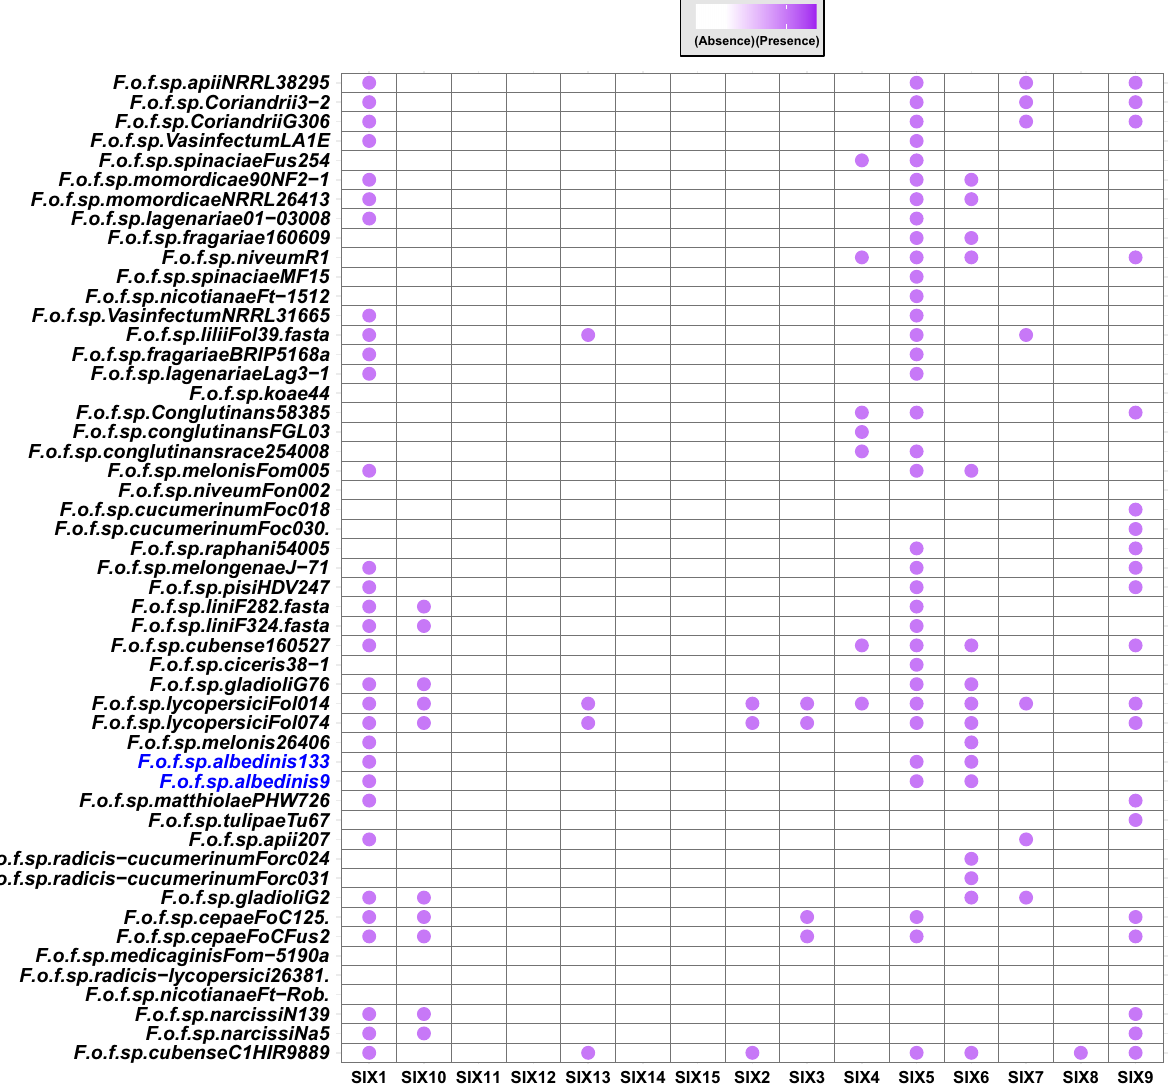
F.o.f.sp.cucumerinumFoc030.F.o.f.sp.cucumerinumFoc018F.o.f.sp.niveumFon002F.o.f.sp.melonisFom005F.o.f.sp.conglutinansrace254008F.o.f.sp.conglutinansFGL03F.o.f.sp.Conglutinans58385F.o.f.sp.koae44F.o.f.sp.lagenariaeLag3−1F.o.f.sp.fragariaeBRIP5168aF.o.f.sp.liliiFol39.fastaF.o.f.sp.VasinfectumNRRL31665F.o.f.sp.nicotianaeFt−1512F.o.f.sp.spinaciaeMF15F.o.f.sp.niveumR1F.o.f.sp.fragariae160609F.o.f.sp.lagenariae01−03008F.o.f.sp.momordicaeNRRL26413F.o.f.sp.momordicae90NF2−1F.o.f.sp.spinaciaeFus254F.o.f.sp.VasinfectumLA1EF.o.f.sp.CoriandriiG306F.o.f.sp.Coriandrii3−2F.o.f.sp.apiiNRRL38295 F.o.f.sp.raphani54005 F.o.f.sp.cubenseC1HIR9889F.o.f.sp.narcissiNa5F.o.f.sp.narcissiN139F.o.f.sp.nicotianaeFt−Rob.F.o.f.sp.radicis−lycopersici26381.F.o.f.sp.medicaginisFom−5190aF.o.f.sp.cepaeFoCFus2F.o.f.sp.cepaeFoC125.F.o.f.sp.gladioliG2F.o.f.sp.radicis−cucumerinumForc031F.o.f.sp.radicis−cucumerinumForc024F.o.f.sp.apii207F.o.f.sp.tulipaeTu67F.o.f.sp.matthiolaePHW726F.o.f.sp.albedinis9F.o.f.sp.albedinis133F.o.f.sp.melonis26406F.o.f.sp.lycopersiciFol074F.o.f.sp.lycopersiciFol014F.o.f.sp.gladioliG76F.o.f.sp.ciceris38−1F.o.f.sp.cubense160527F.o.f.sp.liniF324.fastaF.o.f.sp.liniF282.fastaF.o.f.sp.pisiHDV247F.o.f.sp.melongenaeJ−71 Figure 7. Presence/absence map of SIX protein distribution in the protein repertoire of Foa and other analyzed formae speciales . The bubbles indicate the presence of SIX proteins and the empty boxes represent their absence in each strain. Abbreviations: F (Fusarium); o (oxysporum); f (forma); sp (specialis) . The names following the abbreviations represent the names of the formae speciales ; the abbreviations coming after the names of the formae speciales correspond to the strains belonging to these formae speciales (F.o.f.sp. albedinis 133: Fusarium osysporum forma specialis albedinis Foa